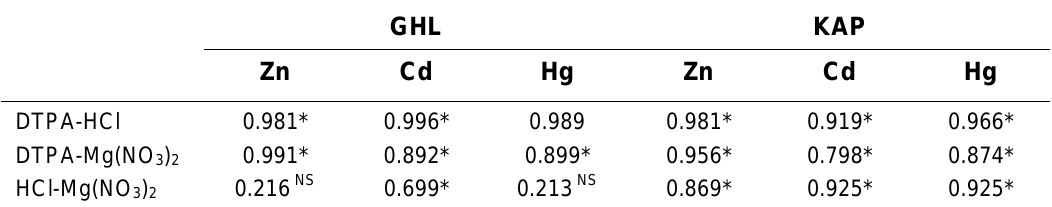
Pearson Correlation Coefficients Between Extractant Methods for